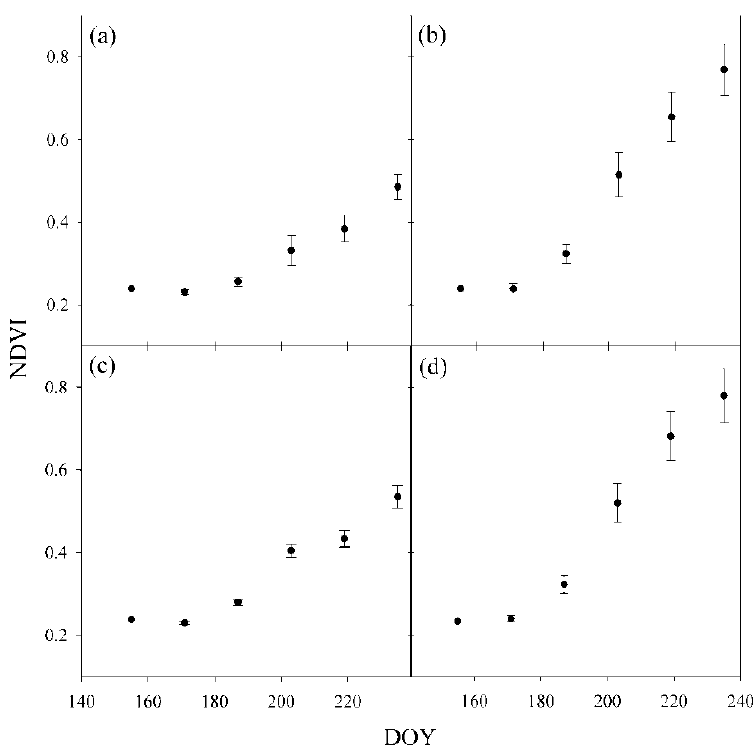
Figure 4. Mean NDVI with standard deviation (bars) for the ( a ) NW, ( b ) NE, ( c ) SW, and ( d ) SE fields on DOYs 155, 171, 187, 203, 219, and 235.